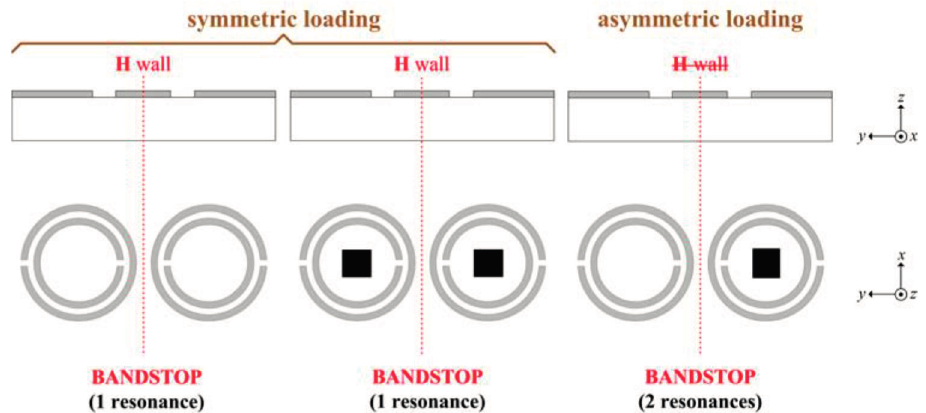
Figure 4. Illustration of symmetry rupture by square-shaped inclusions in the approach based on pairs of resonators, where a CPW is symmetrically loaded with a pair of SRRs. Note that the symmetry planes of the SRRs are not required to be parallel to the longitudinal x -direction, preventing mixed